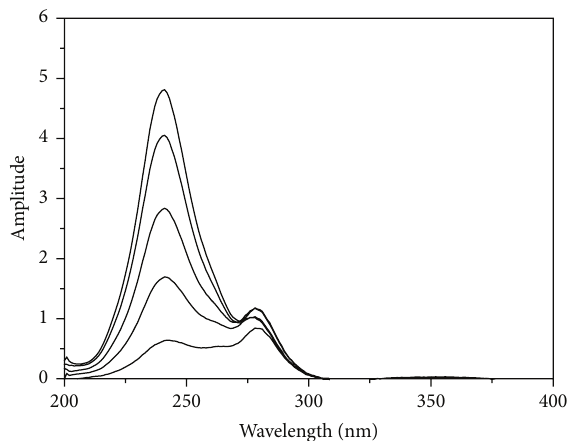
Figure 9: The zero-order absorption spectra of AA obtained by the proposed ratio subtraction method for the analysis of laboratory prepared mixtures after multiplication by the divisor ( 𝑌 󸀠 ).